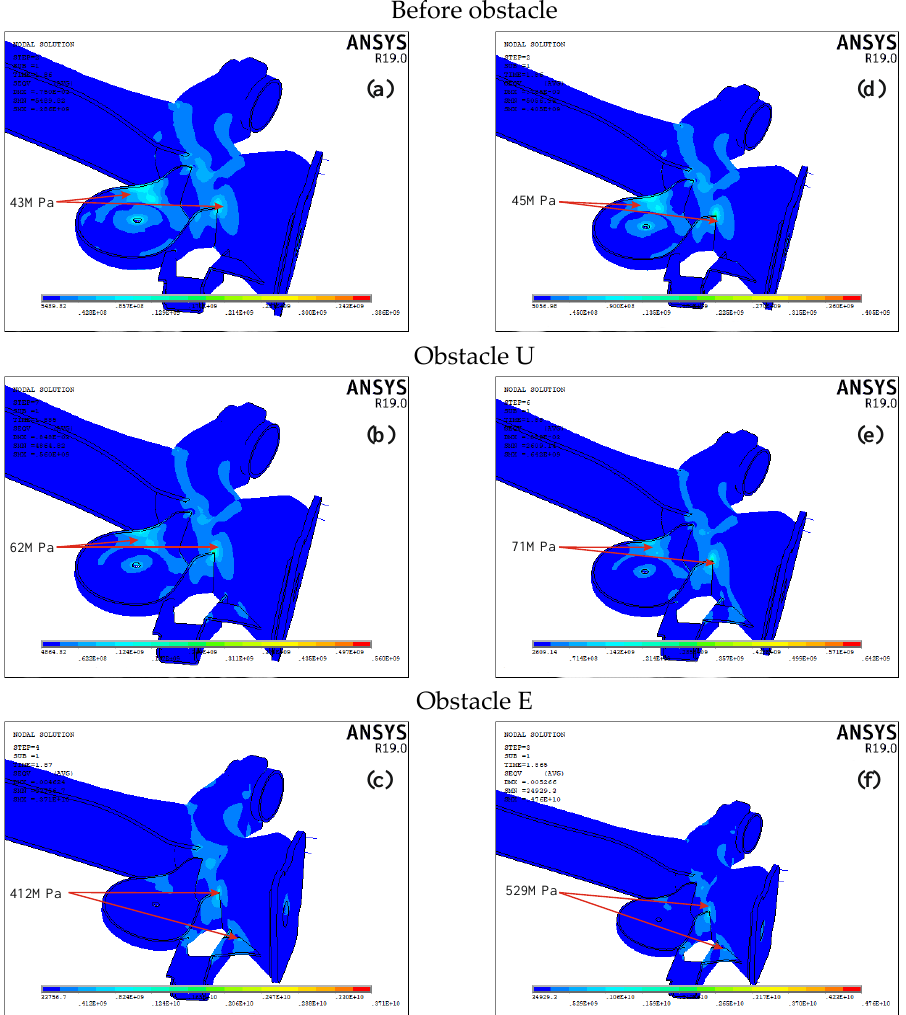
Figure 18. Contour plot of the reduced stresses obtained during overcoming an obstacle at velocity υ = 90 kmh − 1 . ( a ) without motors in wheels and before obstactle, ( b ) without motors in wheels and obstactle U, ( c ) without motors in wheels and obstactle E, ( d ) with motors in wheels and before obstactle, ( e ) with motors in wheels and obstactle U, ( f ) with motors in wheels and obstactle E.